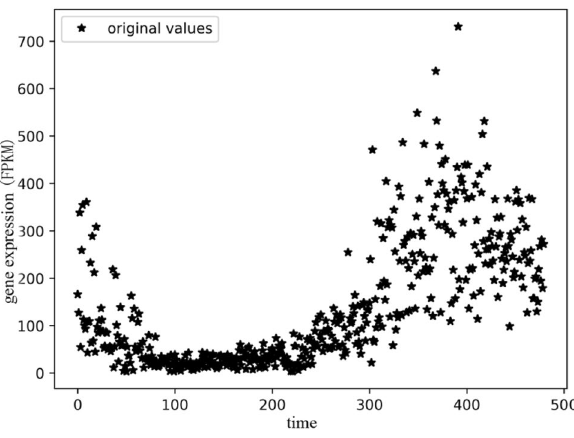
Figure 7. Gene time series expression data, each black star represents the expressed value at the point of time.